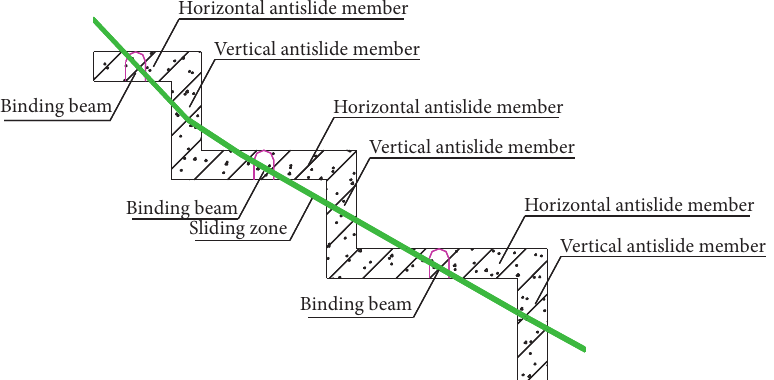
Figure 1: The longitudinal profile of one ASCL along the slip surface of a slope. The zone above the sliding zone is a sliding body while the zone below the sliding zone is a slip bed. Binding beams connect the ASCLs along the horizontal direction.